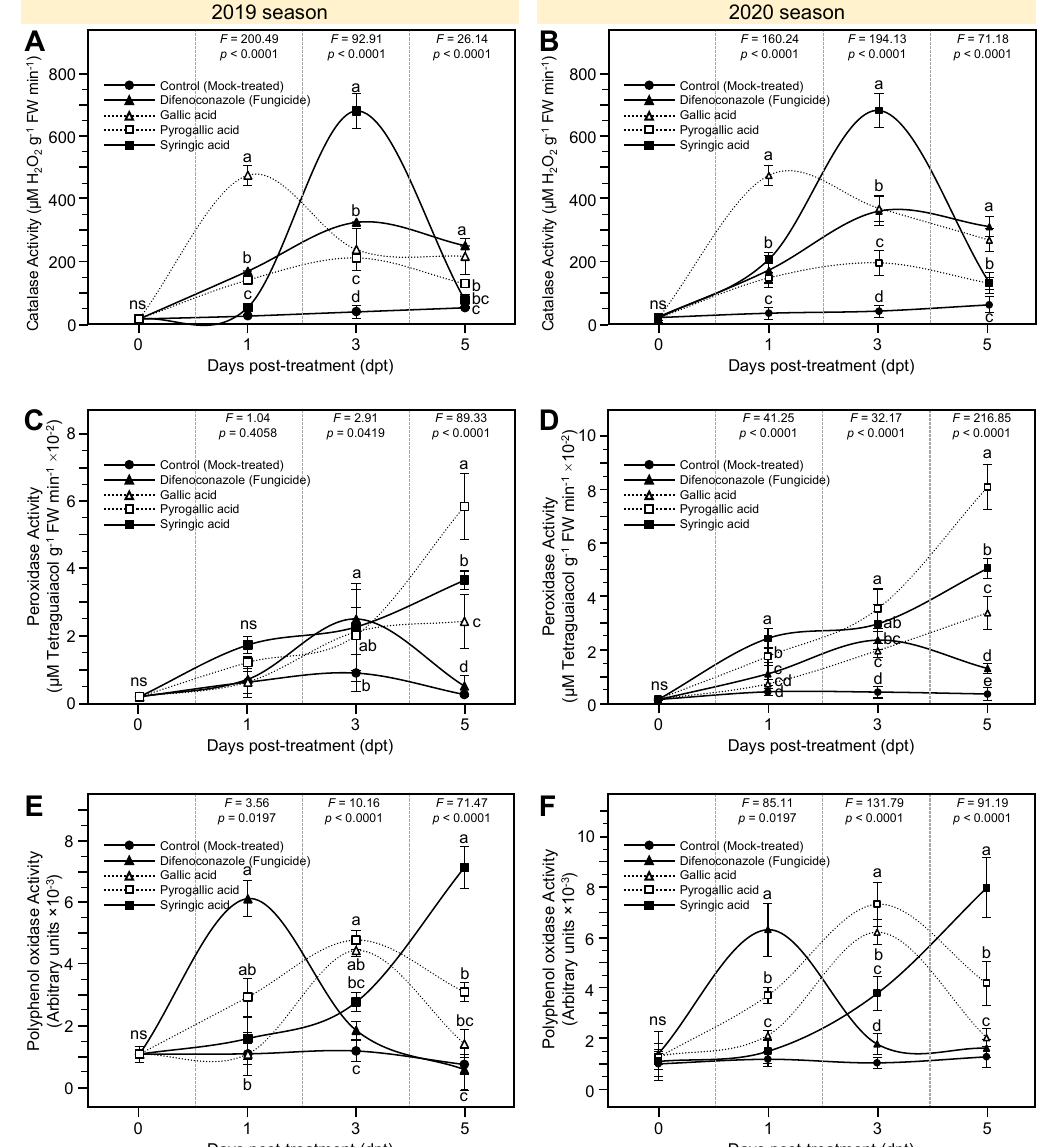
Figure 6. Effects of gallic acid and its derivatives on biochemical analysis of tomato plants (Super strain B–F 1 hybrid) infected with A. solani under greenhouse conditions ( n = 6). ( A , B ) Catalase activity, ( C , D ) peroxidase activity, and ( E , F ) and polyphenol oxidase activity during 2019 and 2020 seasons, respectively. Values represent means of six replications, while whiskers reflect the standard deviation (Means ± SD). Different letters indicate statistically significant differences among treatments, while “ns” or the same letter signify no significant differences among treatments using the Tukey–Kramer honestly significant difference test (Tukey HSD; p < 0.05).